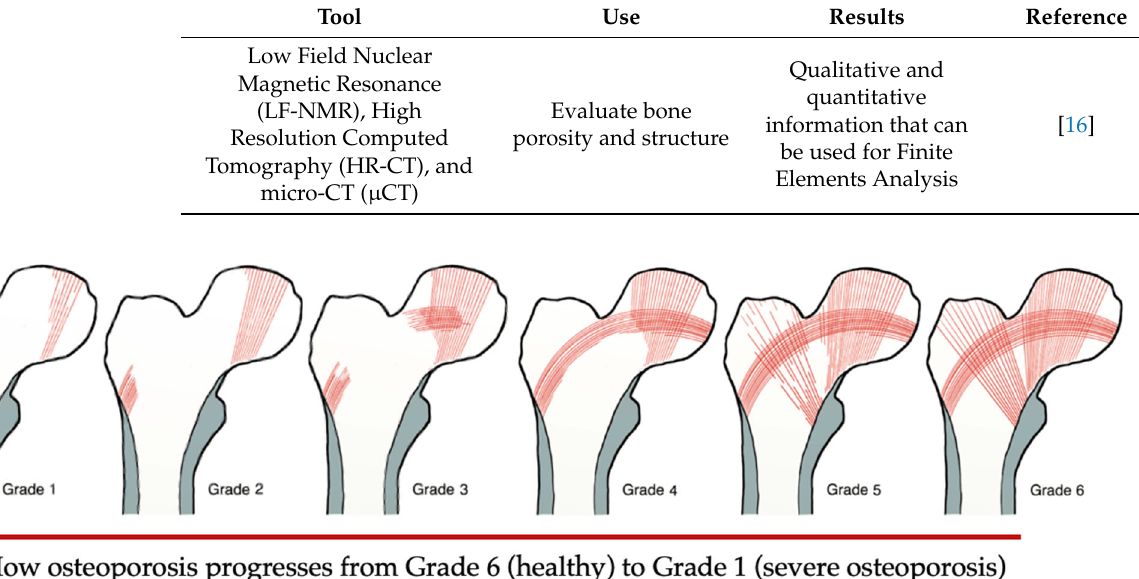
Figure 2. Singh Index grades: Grade 6 The radiograph clearly shows each of the trabecular subgroups. Cancellous bone appears to fill the whole top of the femur. Grade 5: the primary tensile trabecula has been highlighted, and the Ward triangle is clearly visible. Grade 4: the primary tensile trabeculae are significantly diminished, but can still be traced from the lateral cortex to the upper femoral neck. Grade 3: the continuity of the major tensile trabeculae is broken. Grade 2: only the major compressive trabeculae are visible, but other groups have been assimilated. Grade 1: the number and size of the main compressive trabeculae are diminished and no longer prominent. Adapted from reference [17].